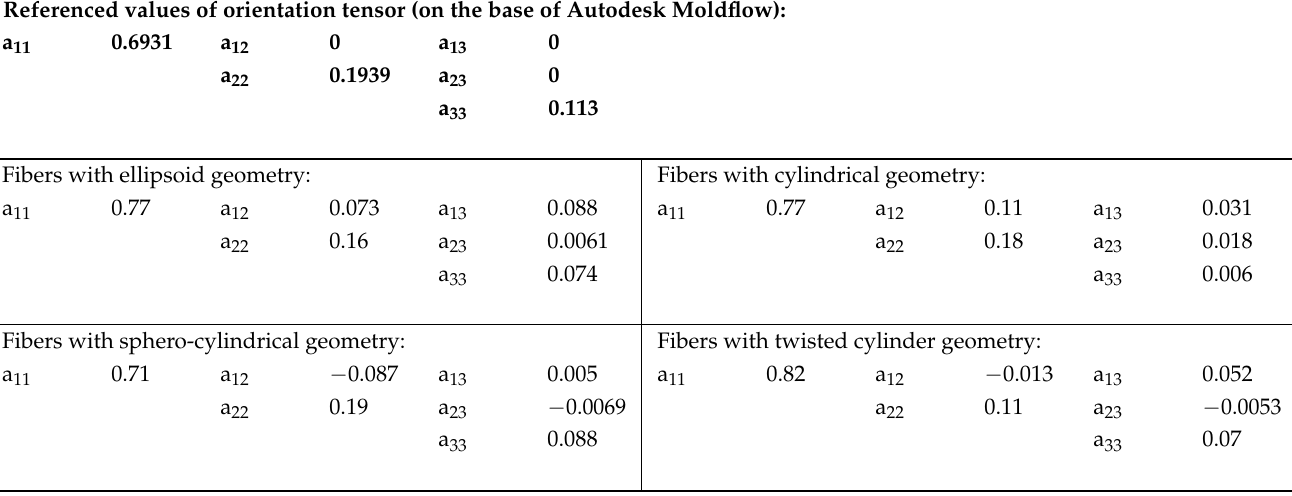
Table 8. Calculated values of the orientation tensor after converting data from Autodesk Moldflow Insight to RVE in Digimat software .